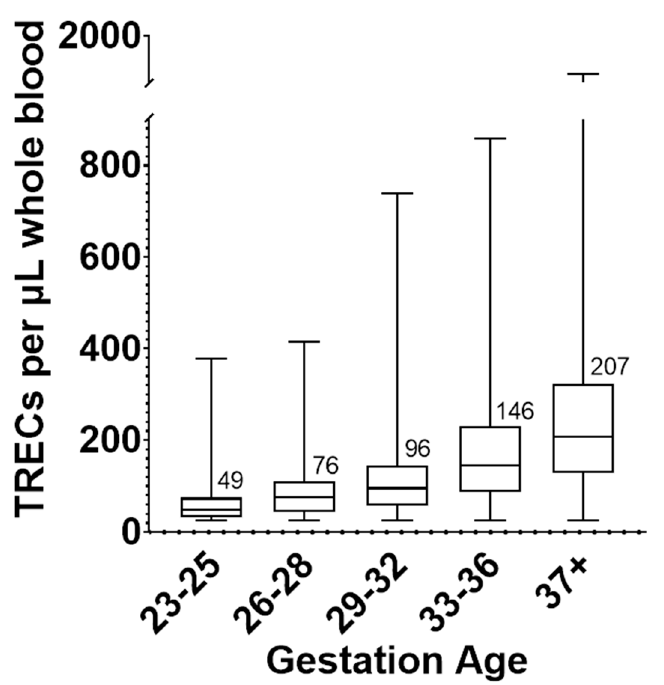
Figure 1. Box and whisker plot of TREC copy number by five gestational age (GA) categories. For 23–25 GA, N = 33; 26–28 GA, N = 54; 29–32 GA, N = 259; 33–36 GA, N = 2164; 37 + GA, N = 5020. The line within each box and the numbers printed next to the box represent the median of each group. The top and bottom of each box are the 25 and 75 percentiles, respectively. The whiskers represent the range of TREC values.